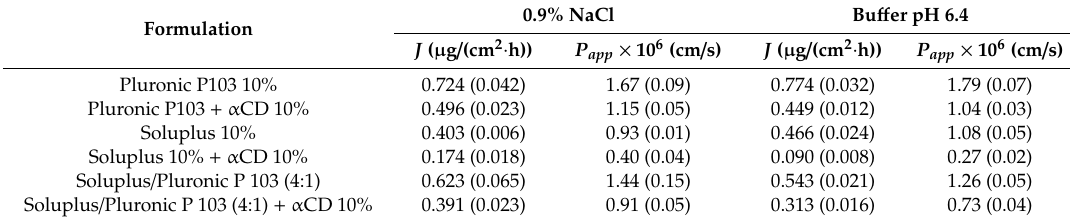
Table S1: Properties of non-loaded Soluplus and Pluronic P103 micelle dispersions in 0.9% NaCl at 25 ◦ C. Figure S1: Structure of single and mixed nanomicelles formed by self-assemble of the amphiphilic block copolymers, and